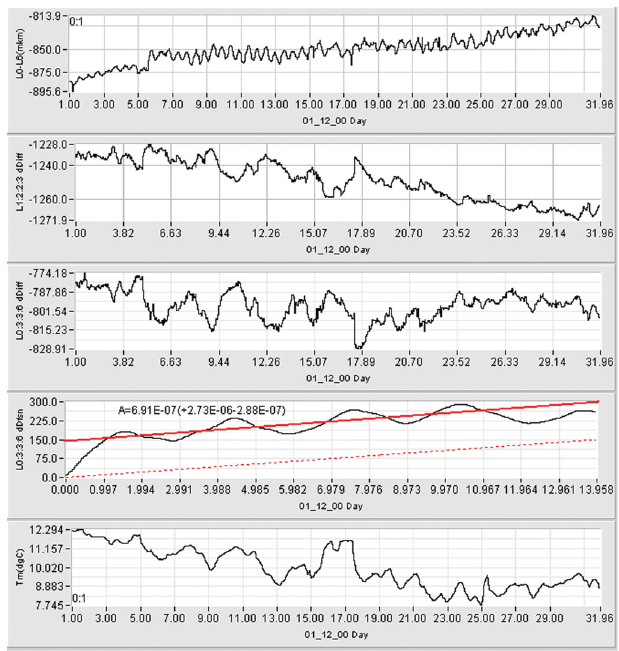
FIG. 41. (Color) Slow ground motion in 120 m deep dolomite mine (Aurora, IL) in December 2000. Top to bottom (a) to (e), see comments in the text [47].